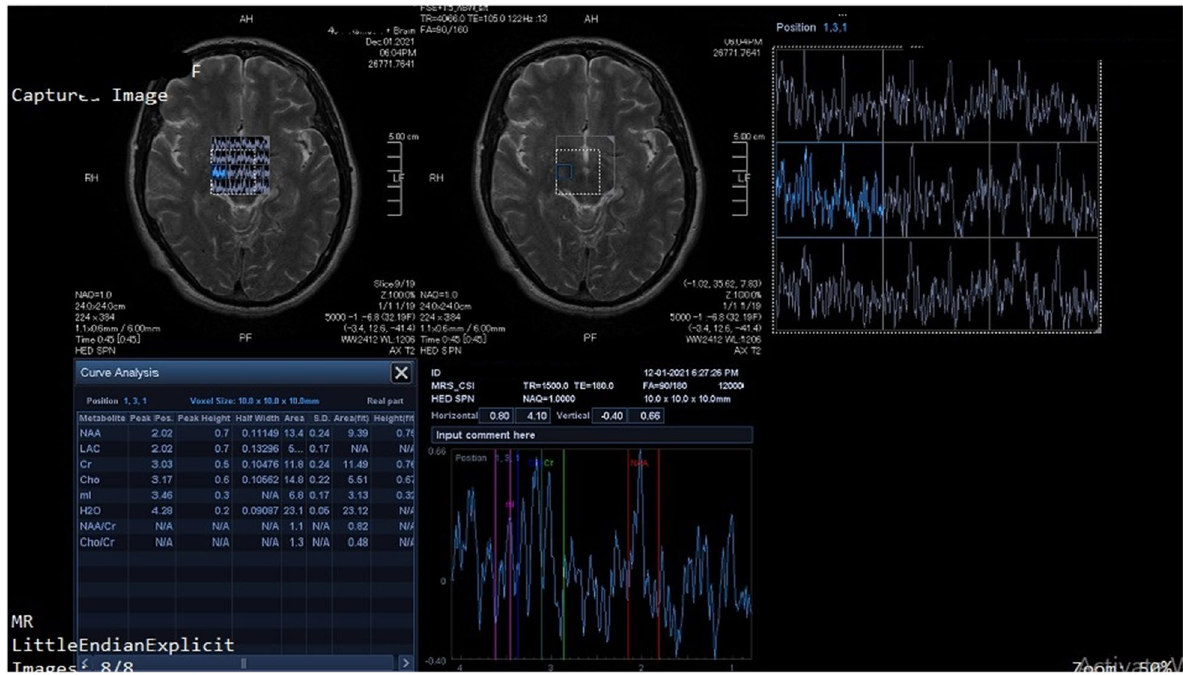
Fig. 2 Multivoxel spectroscopy of the thalamus of 18 years old male patient with childhood absence epilepsy, T 2 weighted image in the axial plane. Placement of the volume of interest over the right and left thalami. It was shown a reduced N ‑acetyl aspartate and N ‑acetyl aspartate/creatine ratio in the right thalamus